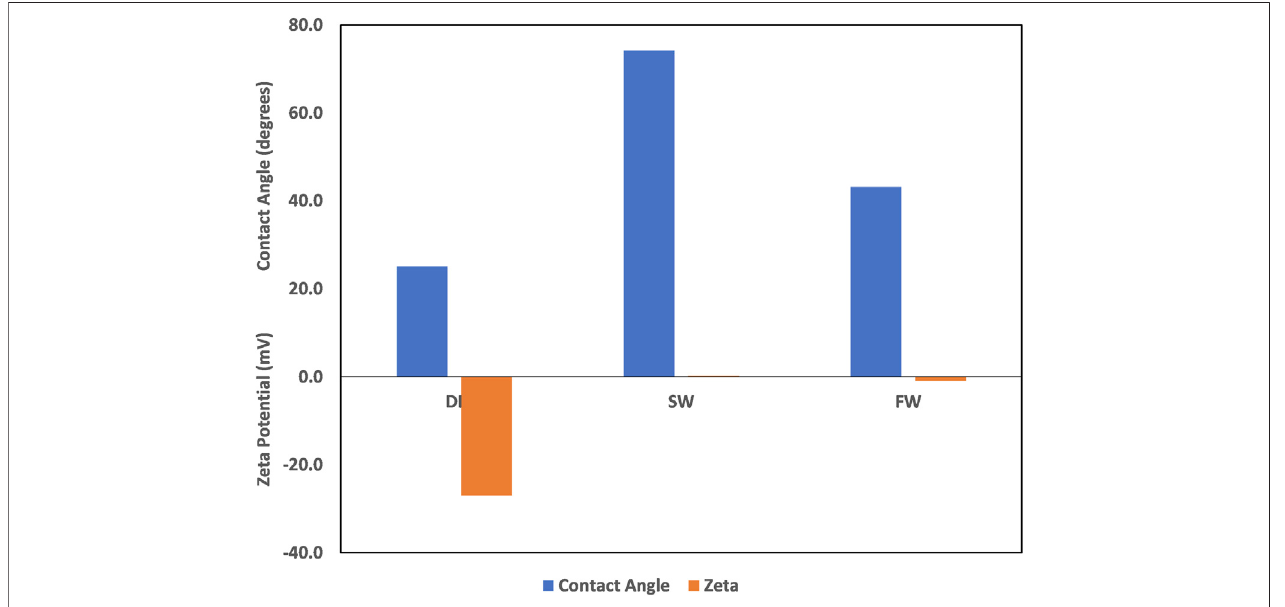
FIGURE 14 | Feldspar sample contact angle in DI, FW, and